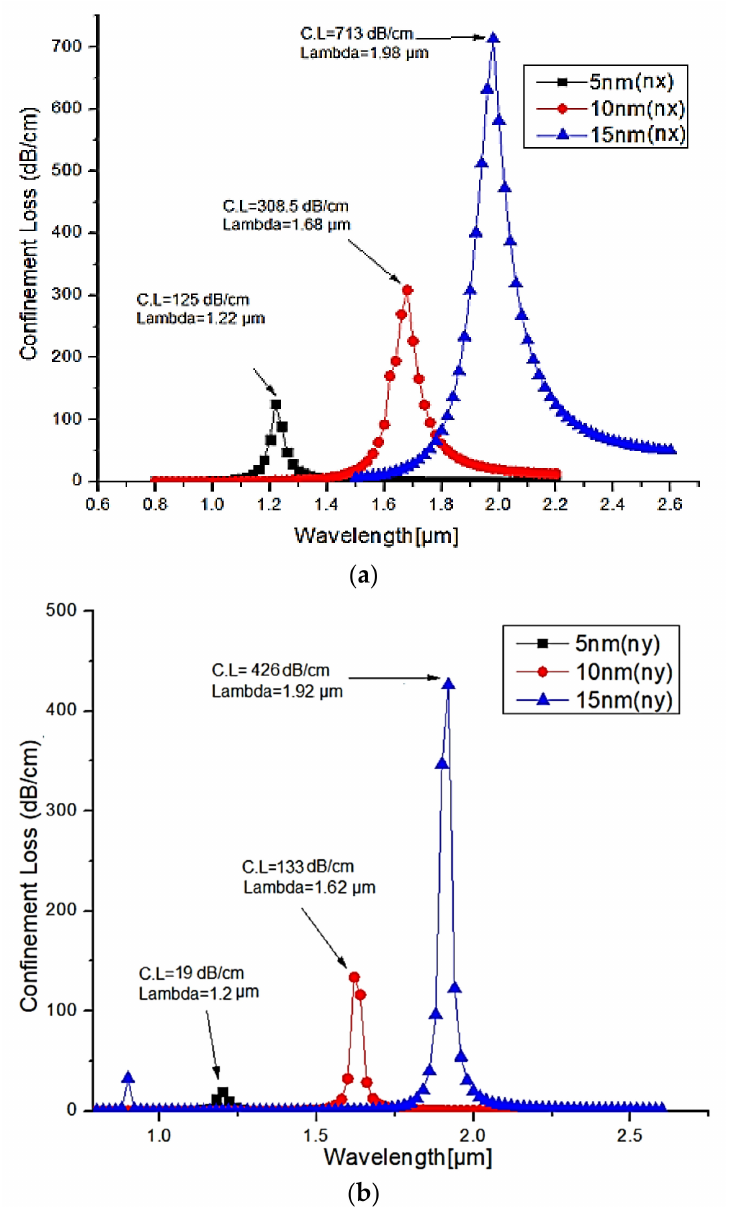
Figure 7. Characteristics of confinement loss for various silver layer thicknesses (5, 10 and 15 nm) ( a ) X-polarized mode ( b ) Y-polarized mode.